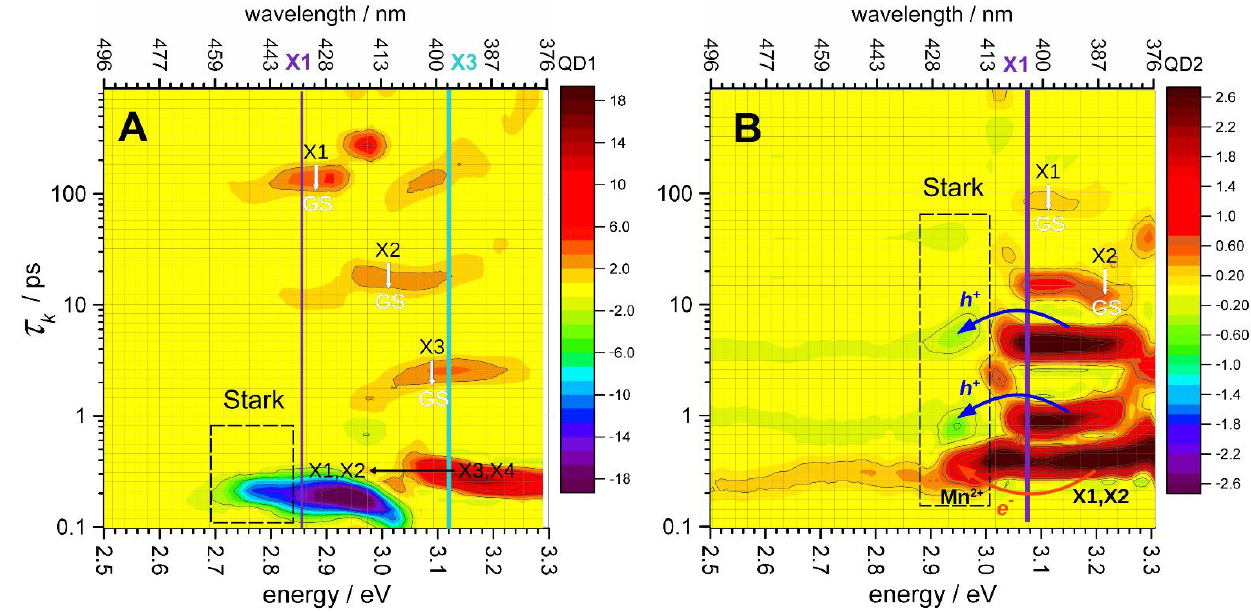
Figure 6. Distribution of the kinetic exponential components calculated by inverse Laplace transform of the TA dynamics of QD-1 ( A ) and QD-2 ( B ) in the range of 2.5 – 3.3 eV using the CONTIN program [52]. The amplitudes of the kinetic components are shown as colored bars. The Stark shift regions are indicated by dashed-line boxes, and the X1 and X3 peaks are marked by vertical lines. The red arrow in Figure 6B refers to the presumable process of Mn 2+ → Mn 1+ reduction, whereas the blue arrows mark the processes of Mn 1+ oxidation and formation of the excited [Mn 2+ ] * in the 2 inhomogeneous Mn 2+ locations.